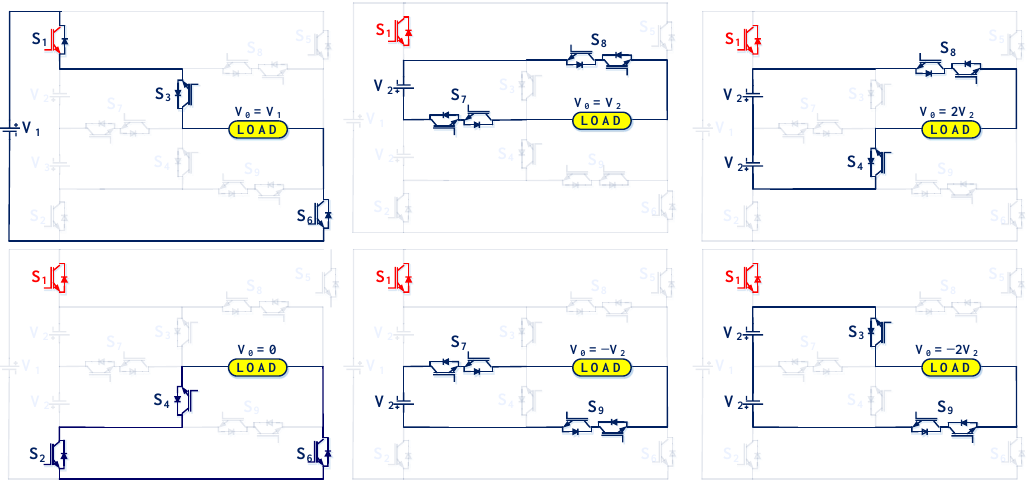
Figure 3. Bypassing of faulted S 1 by body diode and following conduction states.